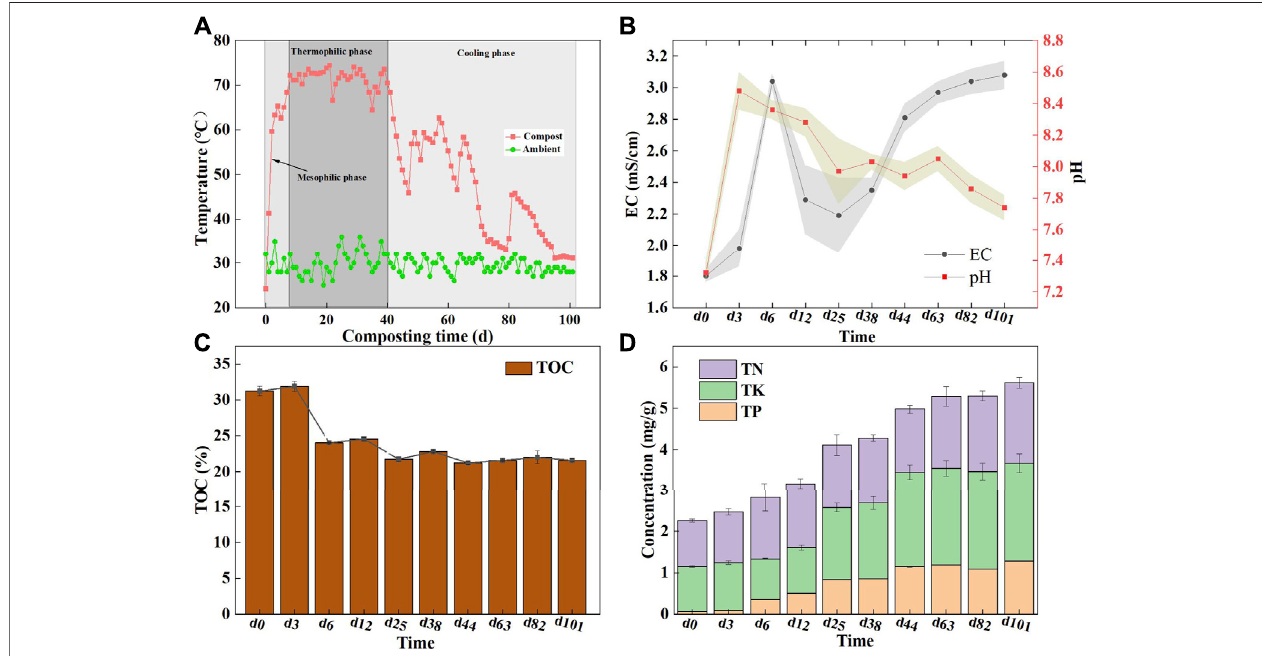
FIGURE 1 | Changes of physicochemical parameters during composting; (A) Temperature during co-compost process; (B) pH and EC, the stripe represents the standard deviation; (C) The concentration of total organic carbon (TOC) and (D) The concentrations of TN, TP and TK.